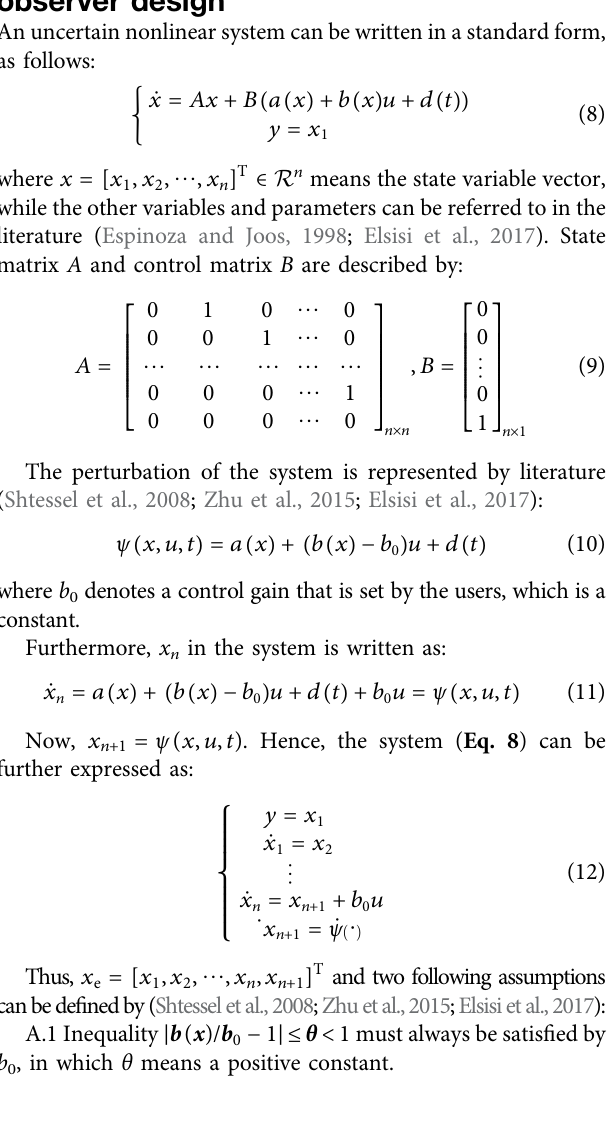
FIGURE 2 | Parameter ranges for different